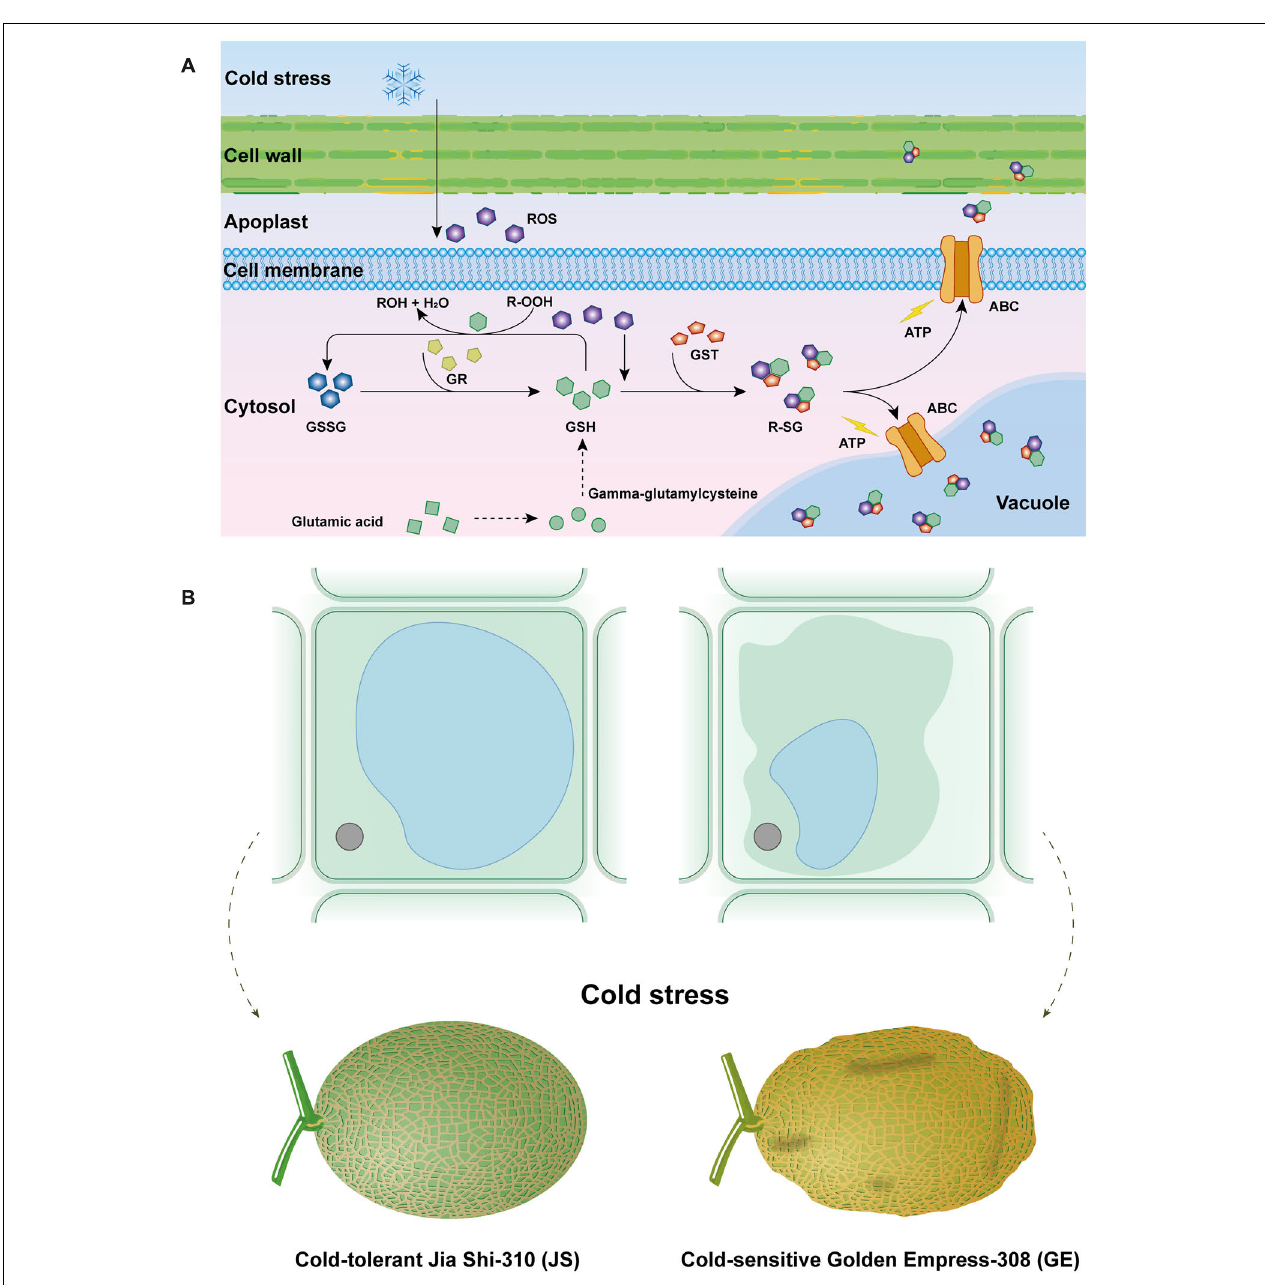
FIGURE 10 | Effect of cantaloupe “glutathione metabolism” process in response to cold stress (A) and osmotic stress caused by cold stress to cantaloupe (B) .